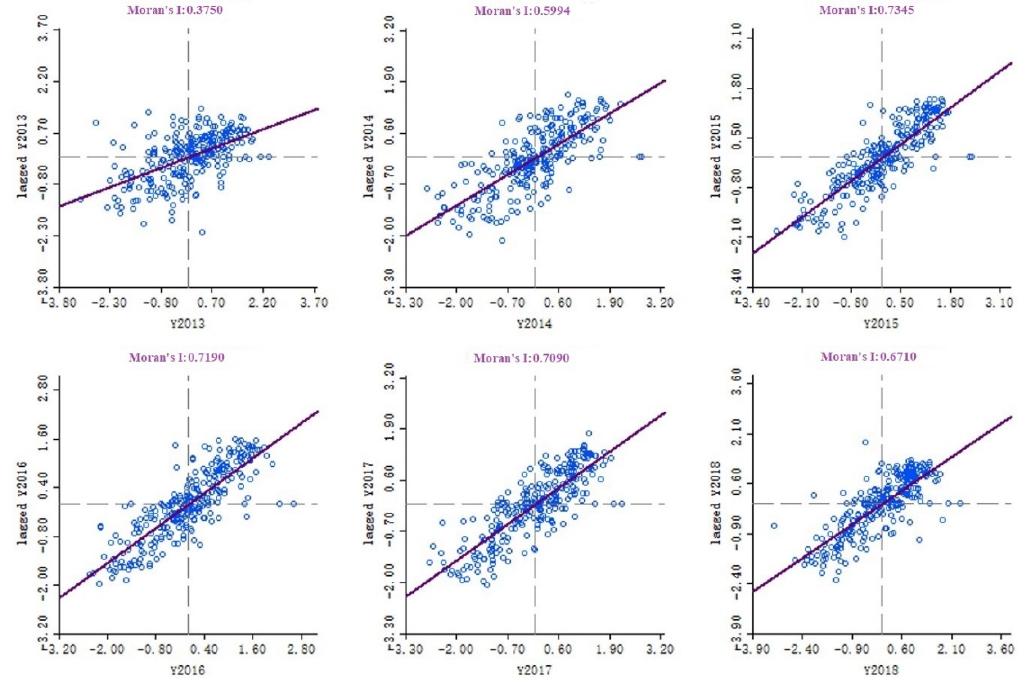
Figure 4. Scatter plot of Moran’s I index in China’s prefecture-level human settlements from 2013 to 2018.